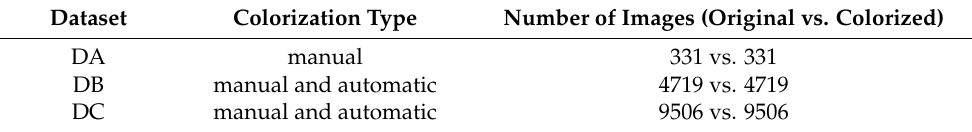
Table 2. General characteristics of the three data sets used (DA, DB, DC). Dataset Colorization